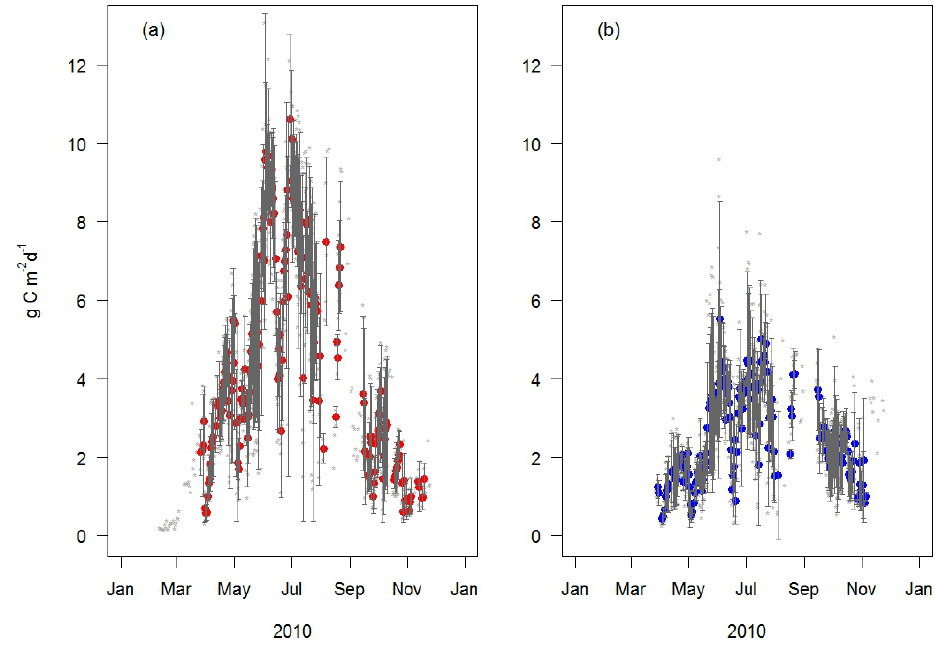
Fig. 2. Average daily soil respiration (gCm − 2 d − 1 ) measured in control (a) and trenching plots (b) with the multiplexed system along the treeline. Data from each single collar are plotted with gray asterisks ( ∗ ). Dots represent daily R s (a) and R h (b) , when data from at least three chambers passed the quality test. Bars are standard deviation of the mean. Table 4. Biomass production (gDWm − 2 ± standard error) in the monitored tree organs between each sampling date. Sampling date Leaves Fruit wood AG wood BG Fine roots Understory